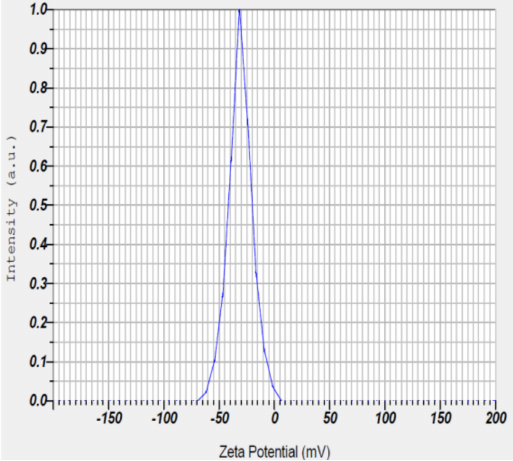
Figure 6. Zeta potential measurement of Psidium guajava